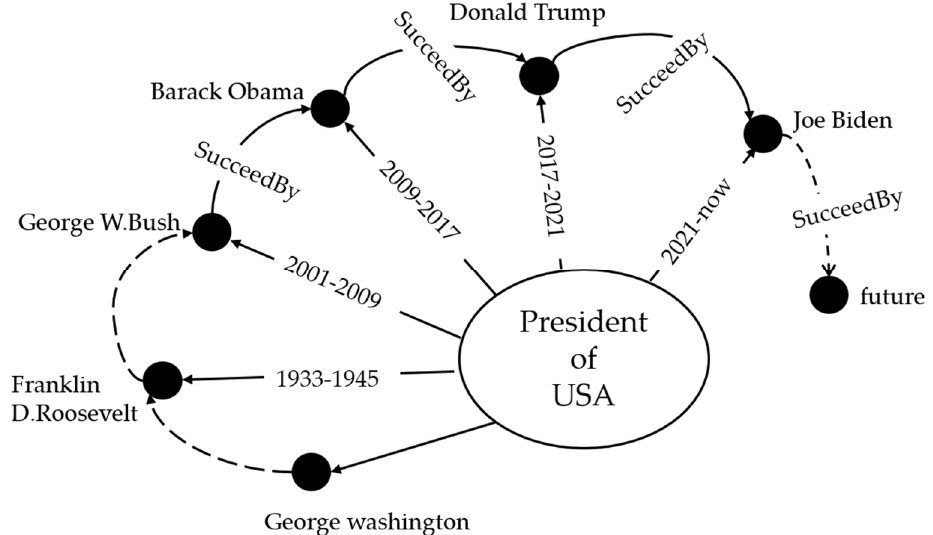
Figure 2. A clip of ICEWS showing records of the incumbents of the U.S. President over different time periods. Not all U.S. presidents in office are listed in the figure, and unlisted presidents and future presidents are represented by dotted lines.